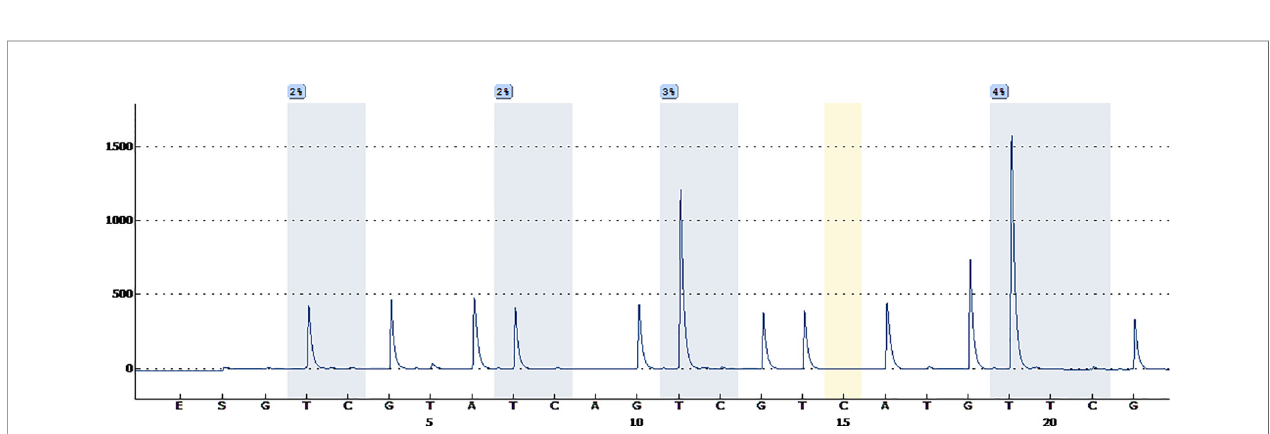
FIGURE 3 | Pyrosequencing demonstrates that no O6-methylguanine-DNA methyltransferase promoter methylation was